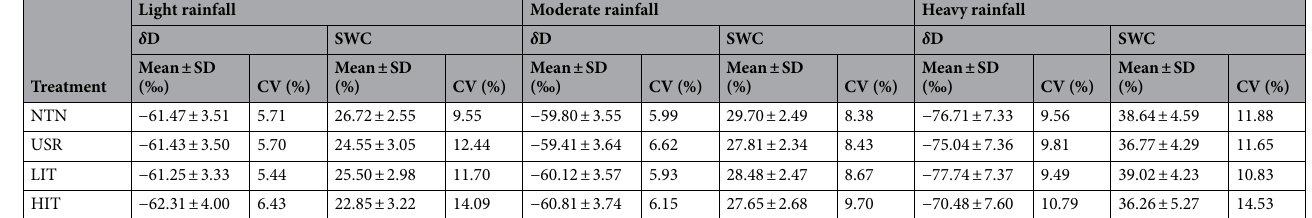
Table 2. Summary statistics of soil water content (SWC) and soil water δ D after the three different rainfall events in the no thinning (NTN), understory removal (USR), light-intensity thinning (LIT) and heavy- intensity thinning (HIT)